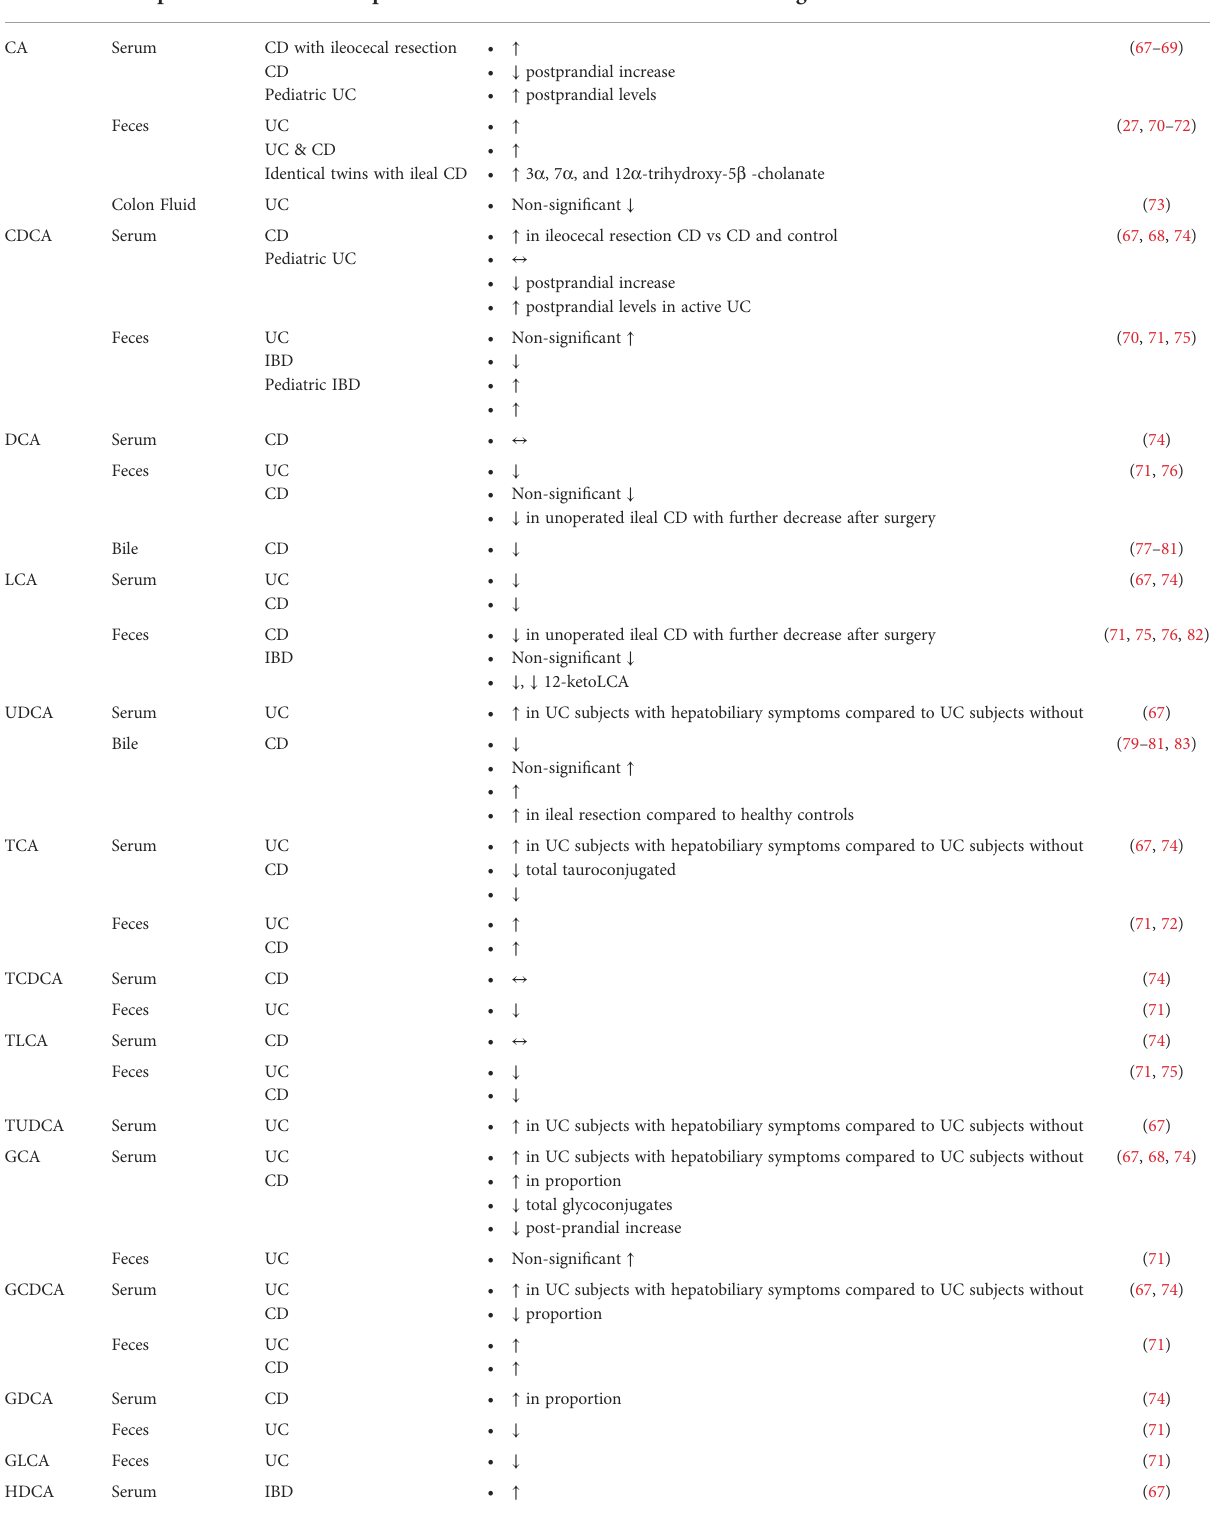
TABLE 2 Bile acid alterations in